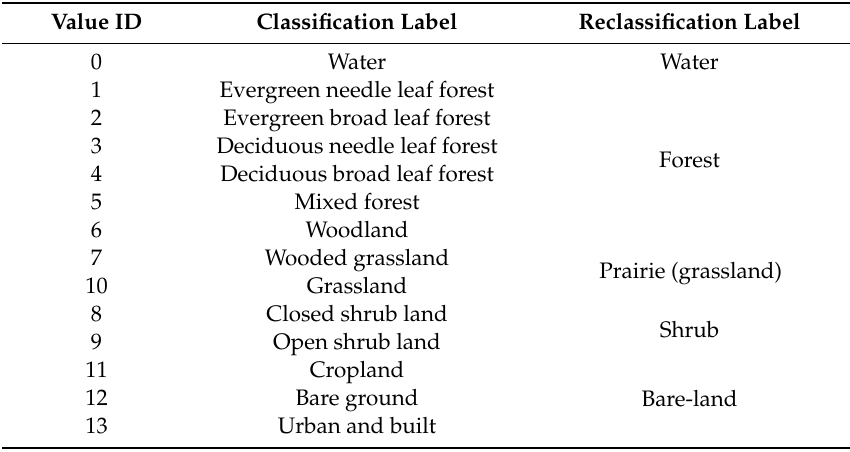
Table A1. AVHRR Global Land Cover classification and reclassification